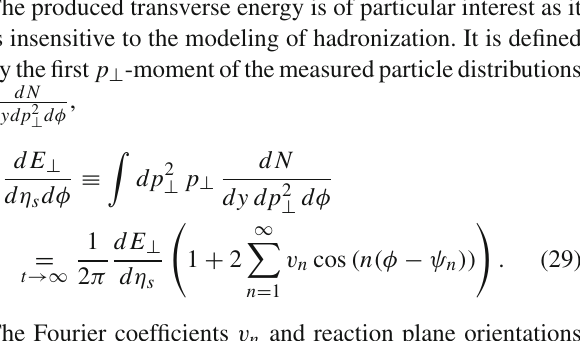
tion F ( r , θ, v z ) = ε 0 e − r 2 / R 2 with a δ 2 , 2 perturbation. Again no significant sensitivity to the initial condition is